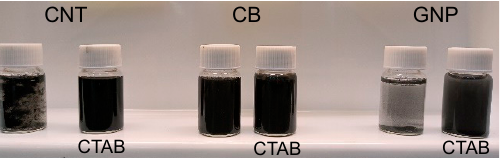
Figure 2. Probe-sonicated nanocarbon dispersions (0.2 mg/mL) without (left vials) and with (right vials) 0.4 mg/mL CTAB.